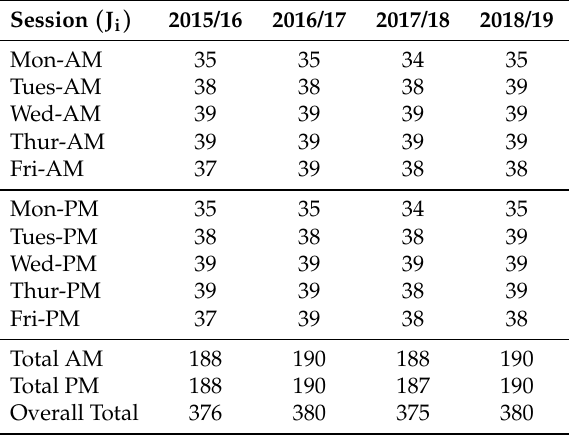
Table A2. Possible sessions for 2015/16, 2016/17, 2017/18, and 2018/19.